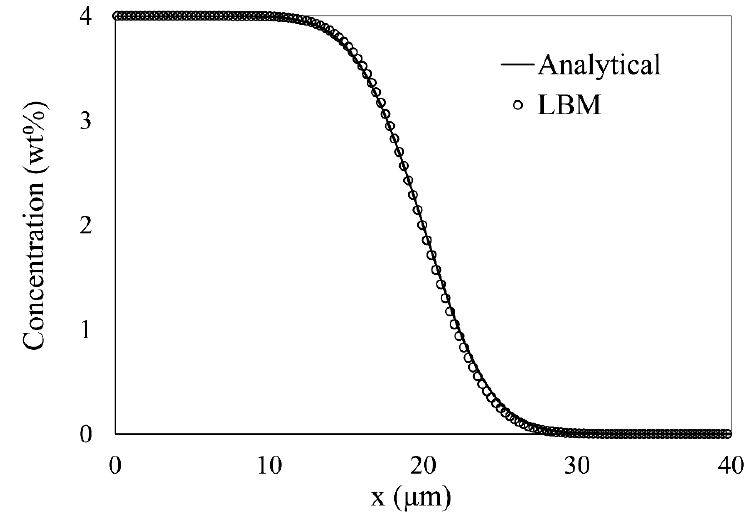
Figure 3. Comparison between the solute distribution calculated using lattice Boltzmann (LB) and analytical models for diffusion-advection under U 0 = 10 mm/s after 2 ms.